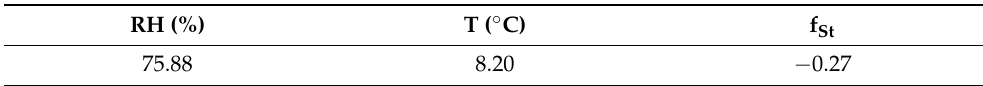
Table 26. Weighted arithmetic means of RH and T, calculated f St .